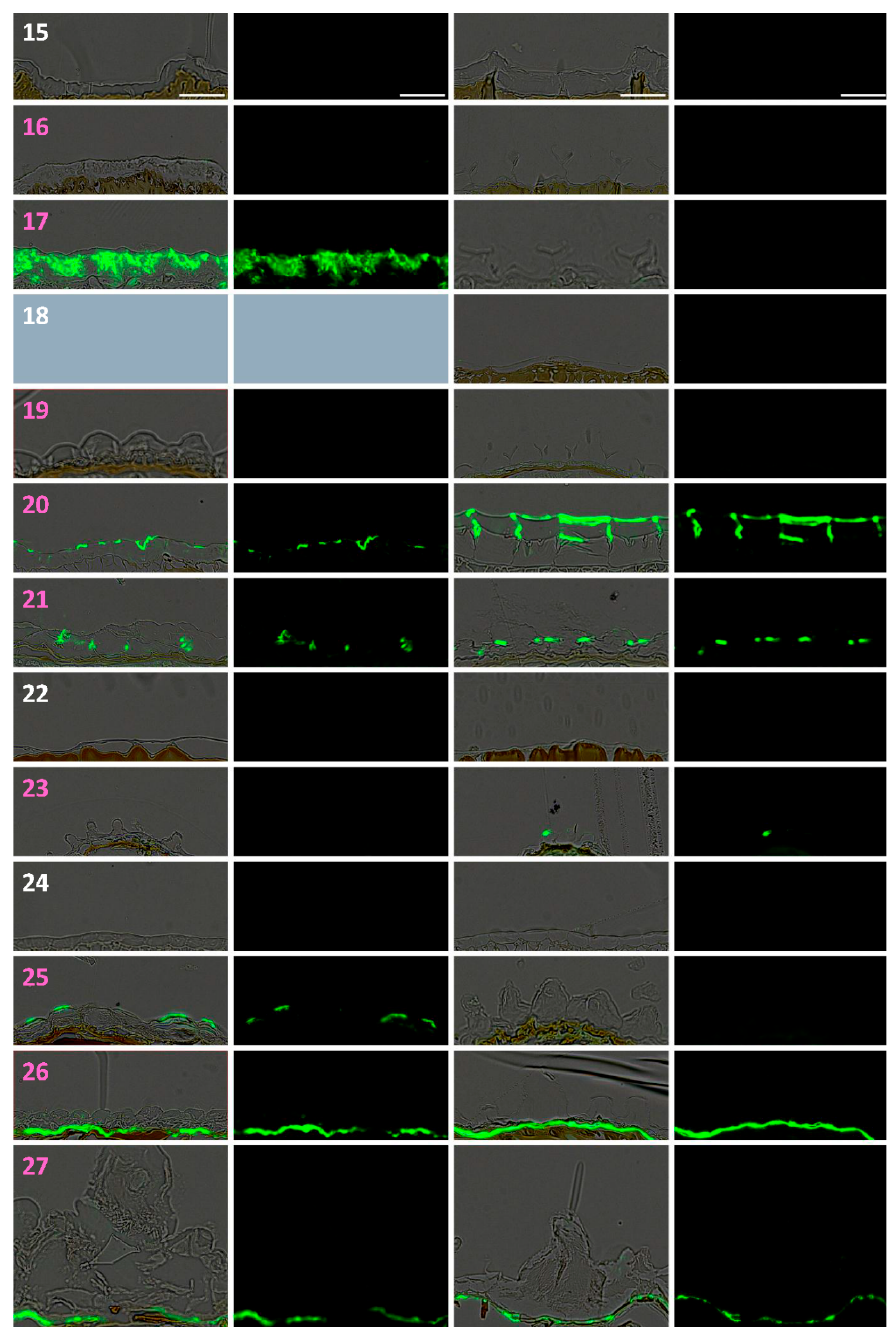
Figure 6. Immunofluorescence survey of mucilage in dry and imbibed seeds using the INRA-RU2 anti-RGI backbone antibody (2 pages). Serial sections of tissue arrays used for Toluidine blue staining were labeled with INRA-RU2 and anti-mouse Alexa488 as a secondary antibody. Note the recurrent occurrence of labeling in most myxospermous species regardless their position in the phylogenetic tree. Species numbers defined in Figure 1 were colored in pink and white for myxospermous and non-myxospermous species, respectively. Grey panels correspond to unavailable or unexploitable samples. Bars: 50 µm.